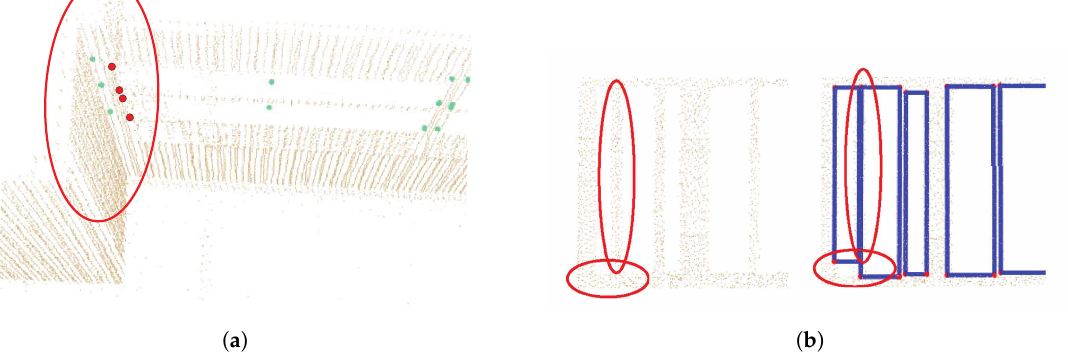
Figure 16. Influence of point density at a transition area. ( a ) is a section of the OKA dataset. Red dots are the manually labeled corners of openings. The green dots are the reconstructed corners. ( b ) is a section of the left part of the Syn. ( b ) dataset. The differences between raw point clouds and the reconstructions are circled in